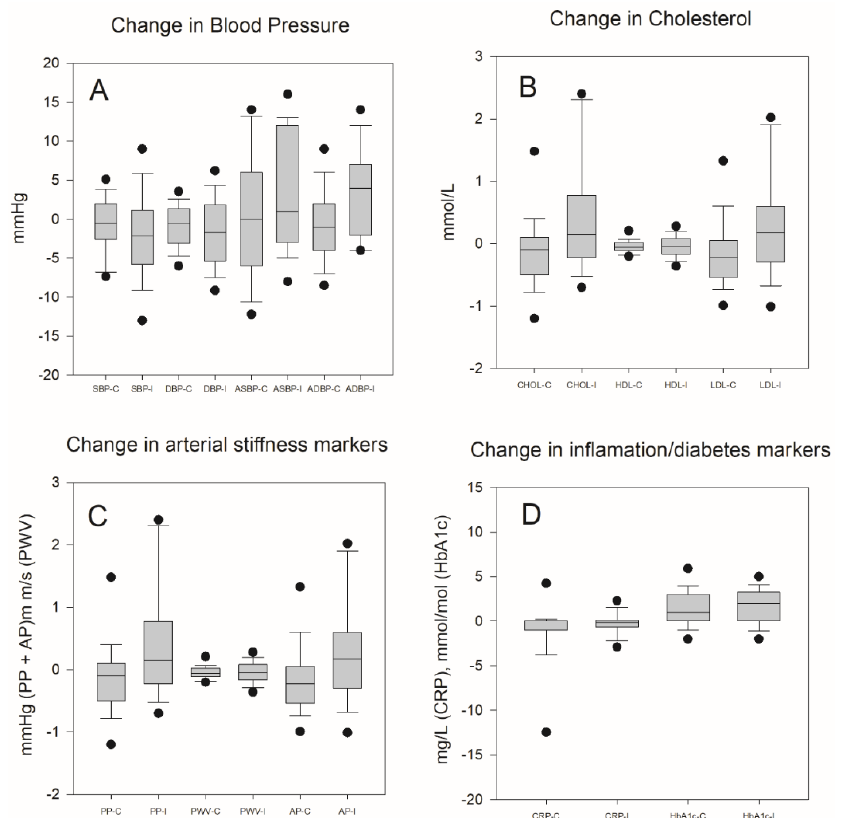
Figure 4. Changes in BP ( A ), CHO ( B ), markers of arterial stiffness ( C ), and ( D ) markers of inflammation and diabetes from baseline to post-intervention. Horizontal line inside box is median, whiskers are 5 and 95 percentiles, dots outliers. SBP = systolic blood pressure, DBP = diastolic blood pressure, ASBP = aorta systolic blood pressure, ADBP = aorta diastolic blood pressure, PP = pulse pressure, AP = augmented pressure, CRP = C-reactive protein, CHOL = total cholesterol, HDL = high-density lipoprotein, LDL = low-density lipoprotein, HbA1c = glycated hemoglobin, C = control group, I = intervention group. Dots are outliers.